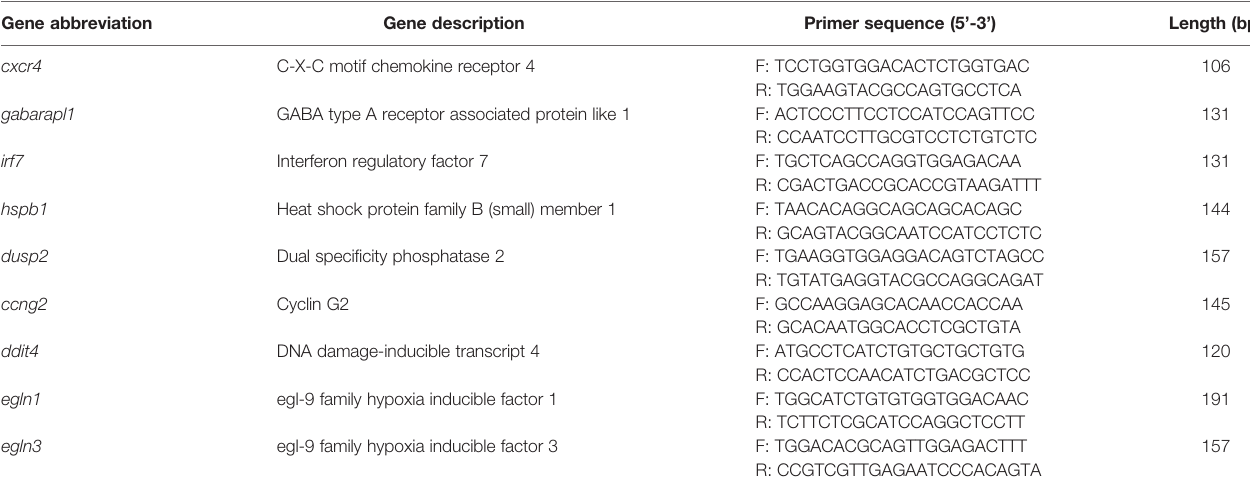
TABLE 1 | Information of the primers used in quantitative real-time PCR